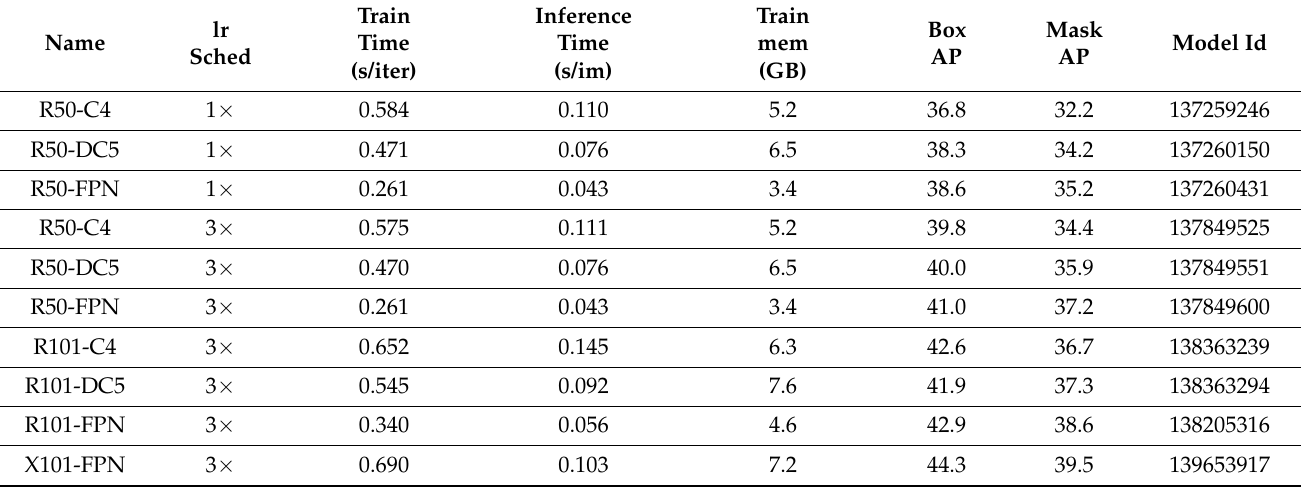
Figure 5. Difference Between Computer Vision Tasks (Adopted from [25]). Table 2. Detectron2 COCO Instance Segmentation Baselines Models with Mask R-CNN